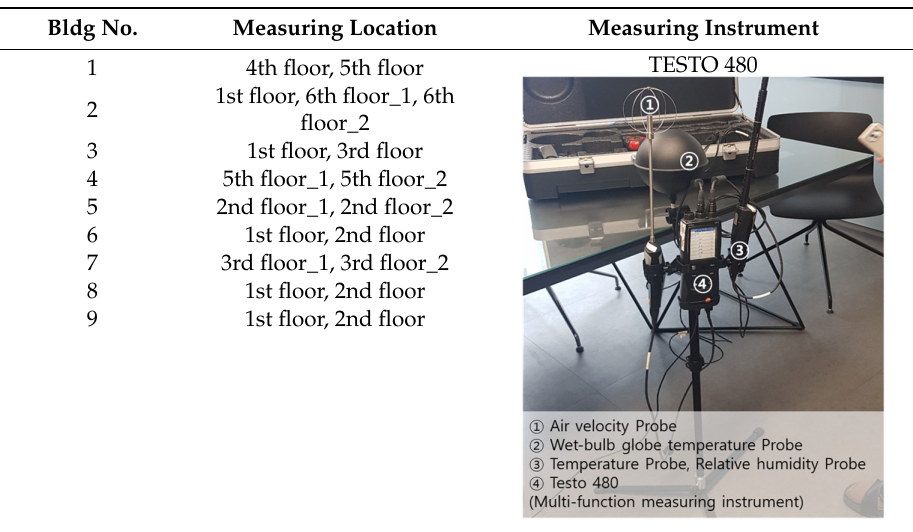
Table 4. Measuring location and